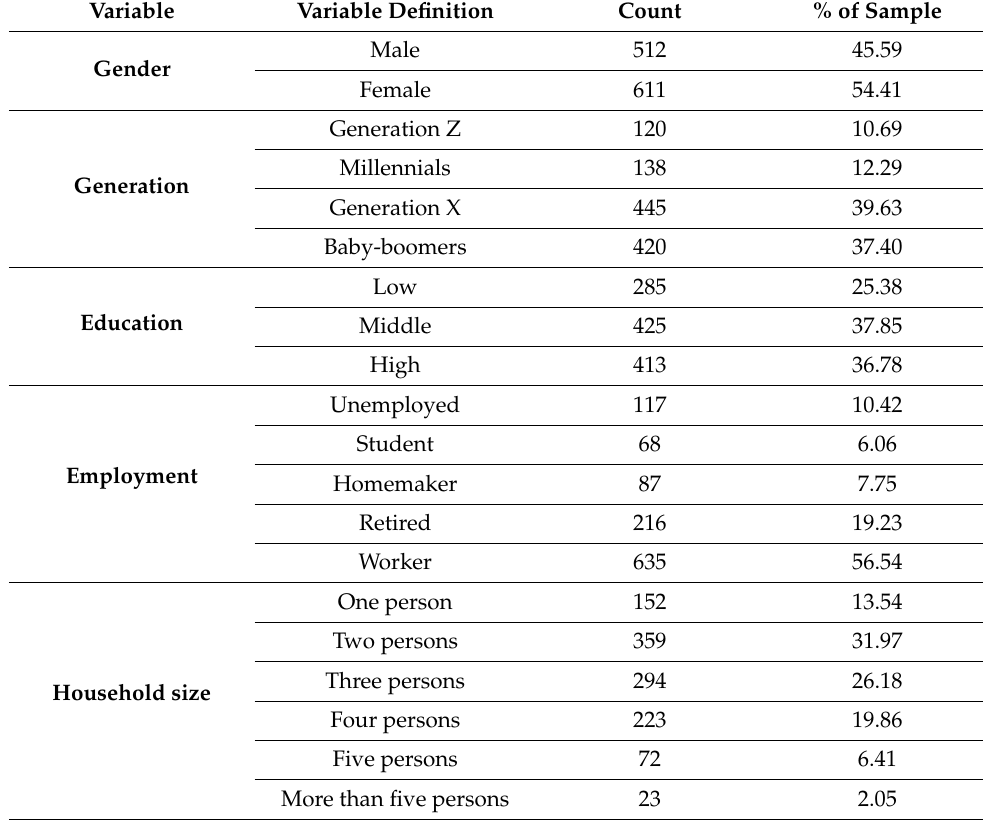
Table 1. Socio-demographic characteristics of the sample, n = 1123.